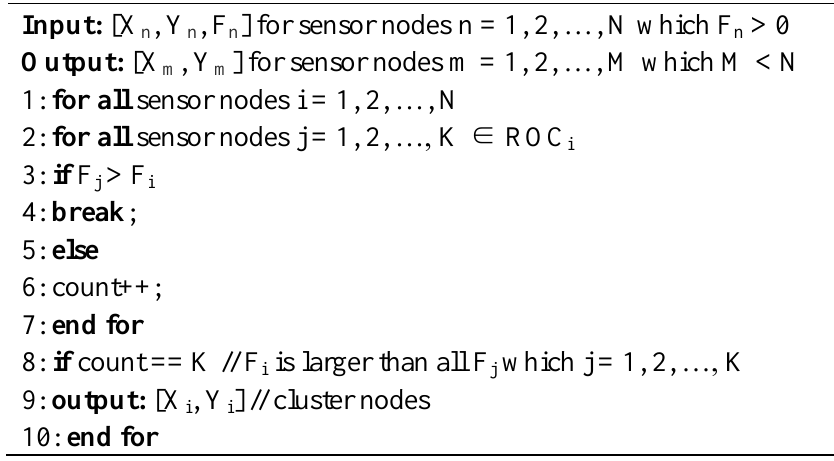
Algorithm 1. Finding the cluster